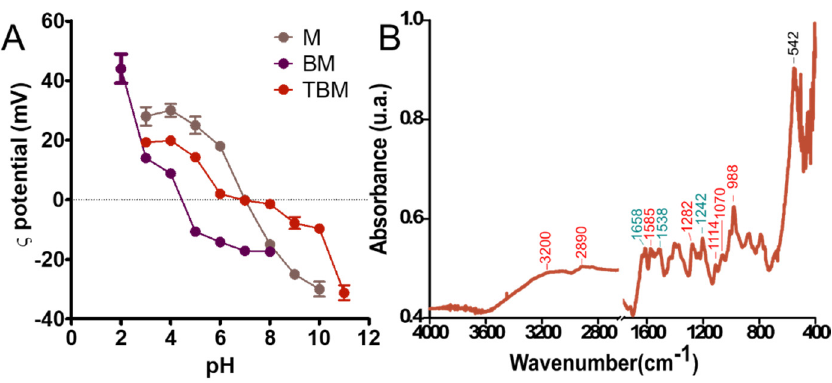
Figure 2. ζ potential of M, BM and TBM ( A ). ATR-FTIR spectra of TBM ( B ). The signal corresponding to di ff erent elements are marked in red (DOXO), green (AR-3 mAb) and black (magnetite).